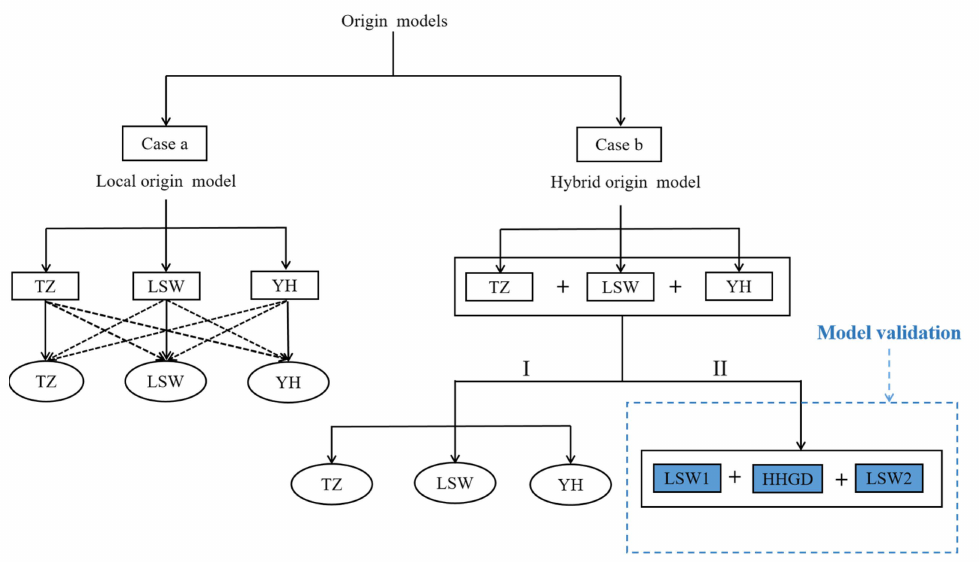
Figure 3. Experimental scheme of the soluble solids content (SSC) and acidity (pH) detection models for local and hybrid origins. Note: Rectangles indicate the calibration set; ovals indicate the prediction set; and blue-filled rectangles indicate the full sample